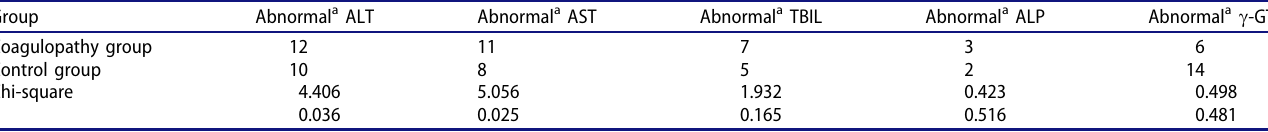
Table 3. The correlation between biochemical test index with coagulopathy in COVID-19.